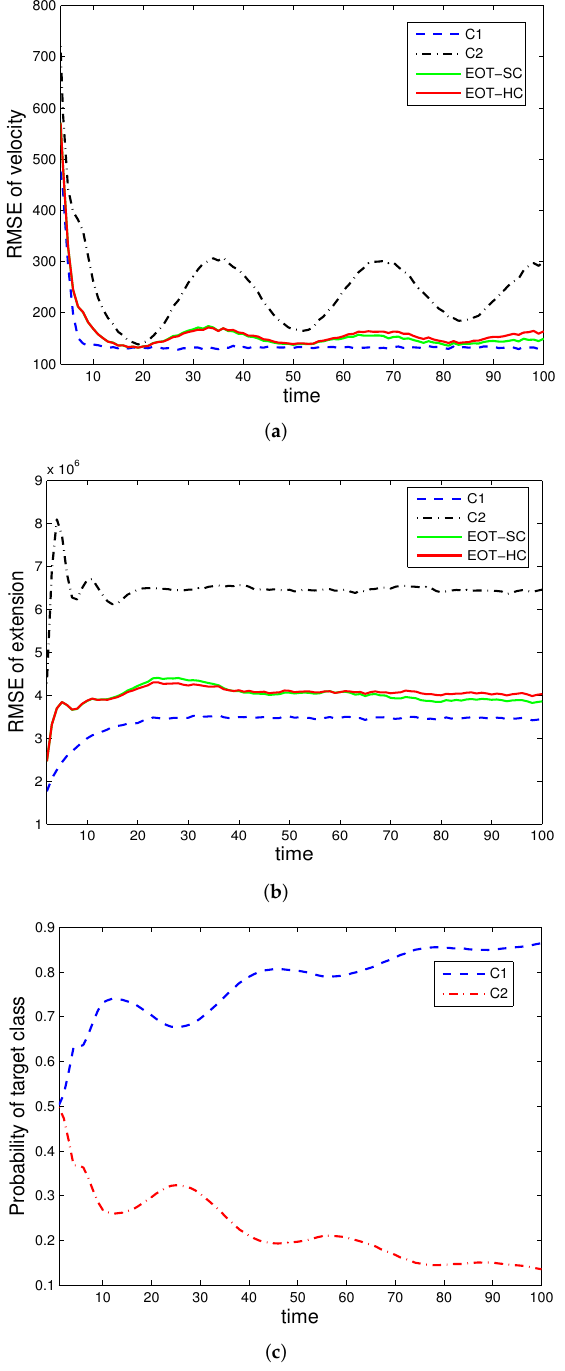
Figure 1. EOT-SC and EOT-HC using kinematic data, class c 1 is true: ( a ) RMSE of velocity, ( b ) RMSE of extension, ( c ) Probability of target